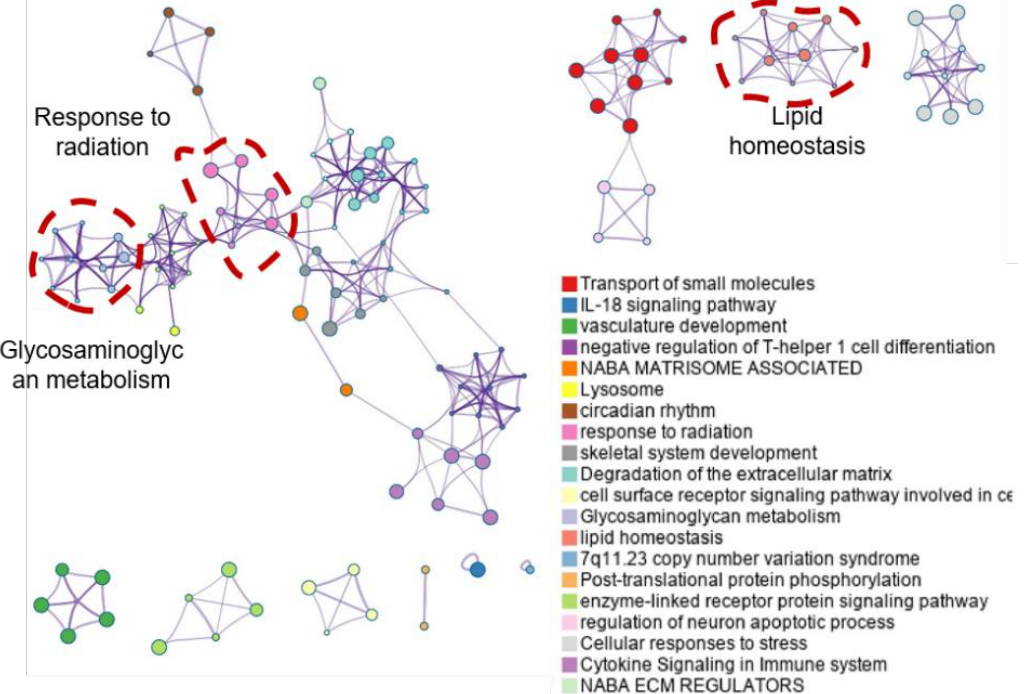
Figure 7. Metascape analysis of enriched pathways using upregulated DEGs in higher intervention dosage.